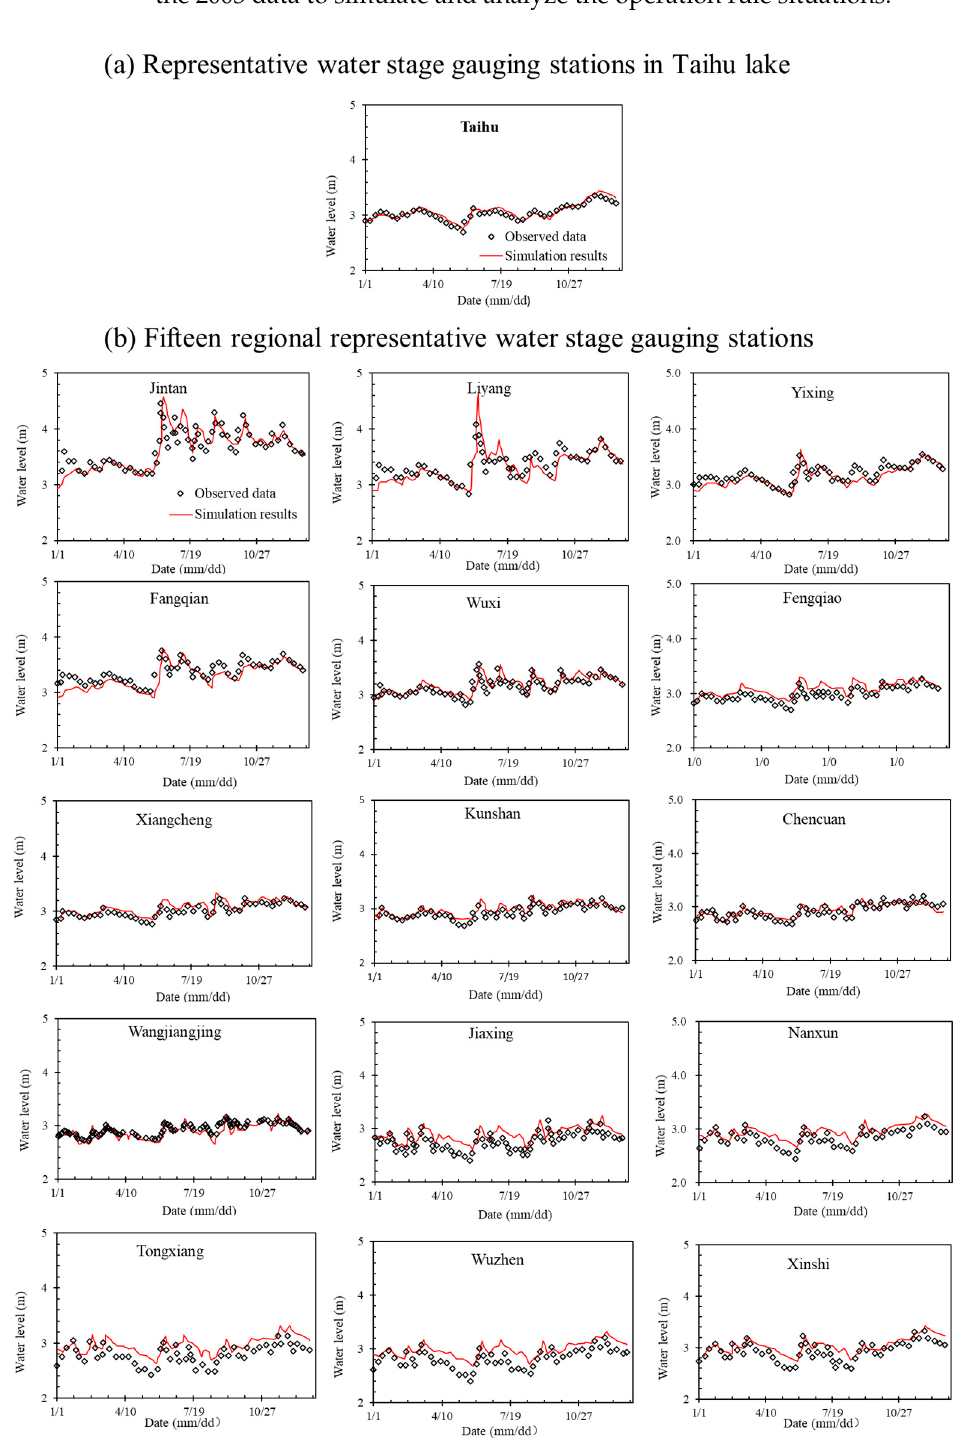
Figure 9. The comparison of simulated and observed water surface elevation in representative stations in 2000.